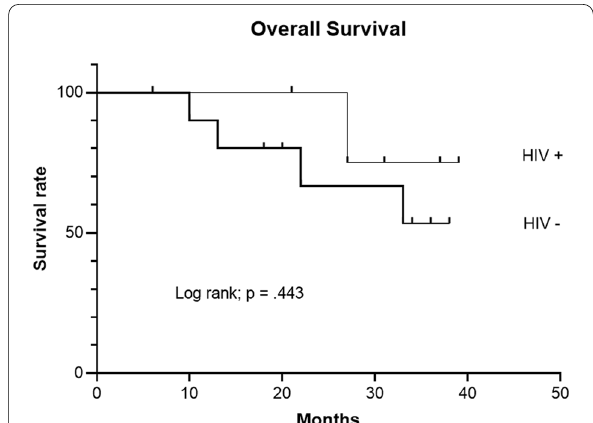
Fig. 1 Overall survival after liver resection in HIV-positive and HIV-negative patients